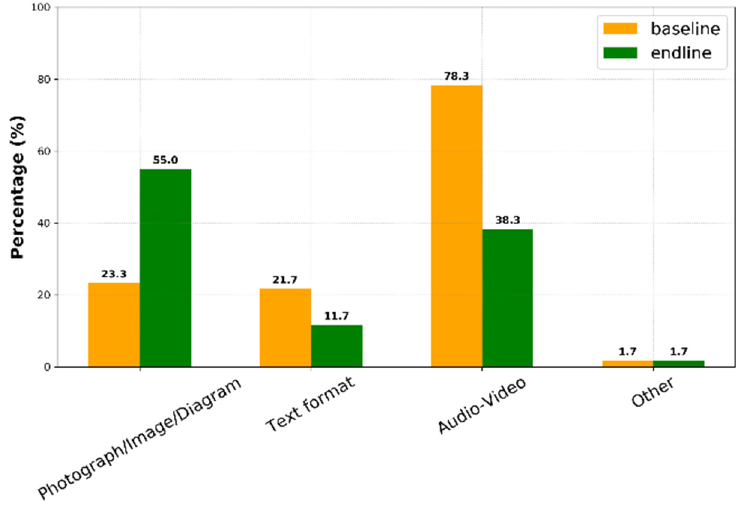
Figure 8. Farmers’ preferred formats for receiving hydroclimatic information service in the Lower Bengal Delta.